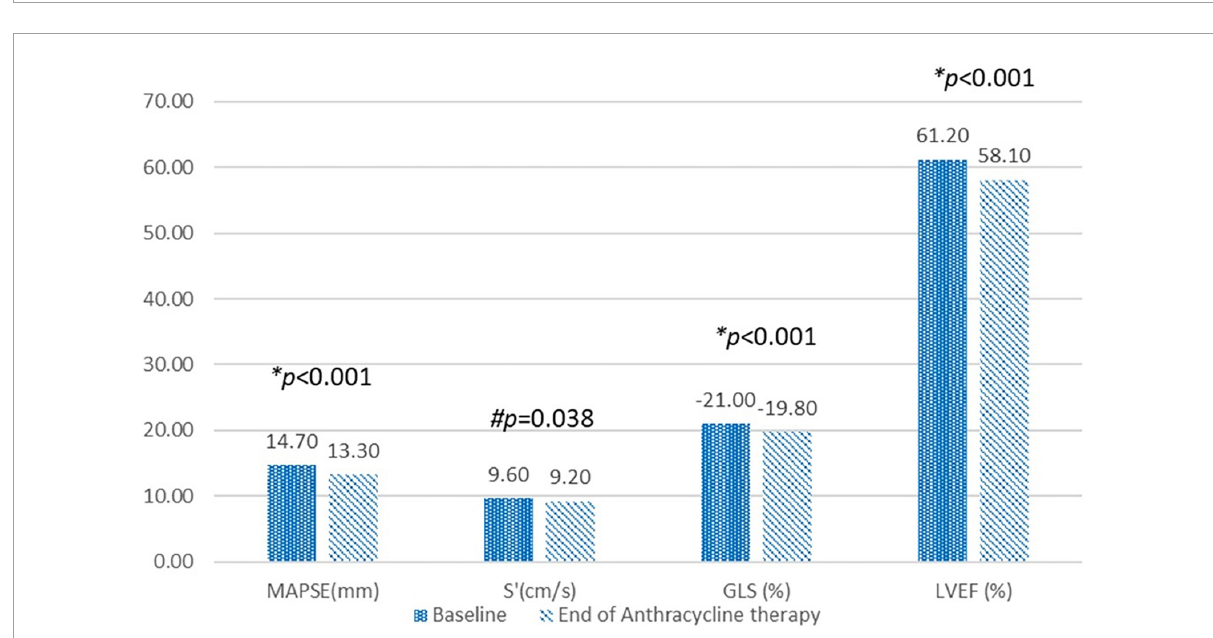
FIGURE4 Compare echocardiographic variables at the baseline and at the end of anthracycline therapy. MAPSE, Mitral annular plane systolic excursion; S’, Mitral annular peak systolic tissue Doppler velocity; GLS, Global longitudinal strain; LVEF, left ventricular ejection fraction. ∗ p- value calculated using paired t -test. # p- value calculated using Wilcoxon signed rank